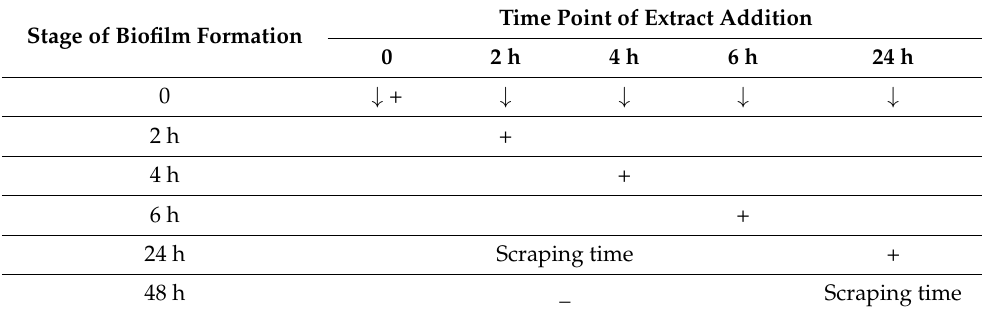
Table 3. Protocol for the addition of extract at different time